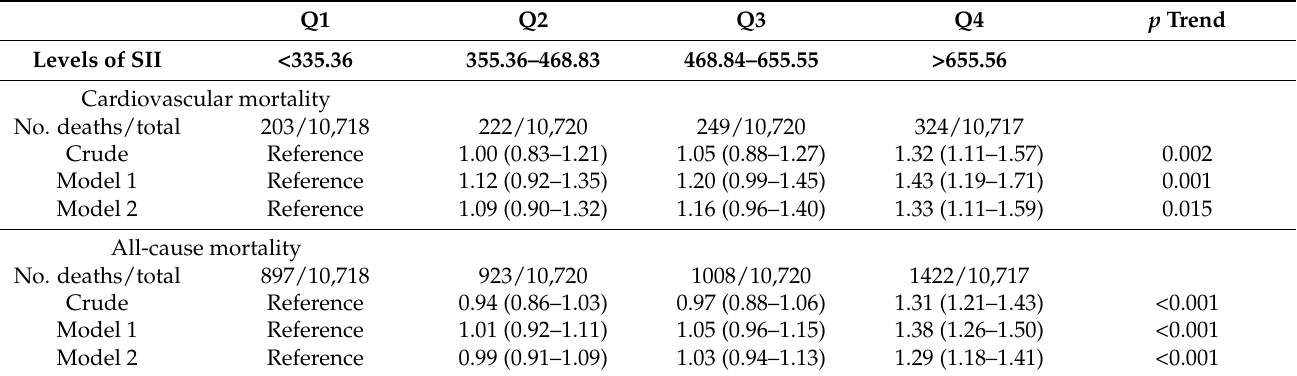
Table 3. HRs (95% Cis) of cardiovascular diseases and all-cause mortalities according to quartiles of SII among the general adult population in NHANES,